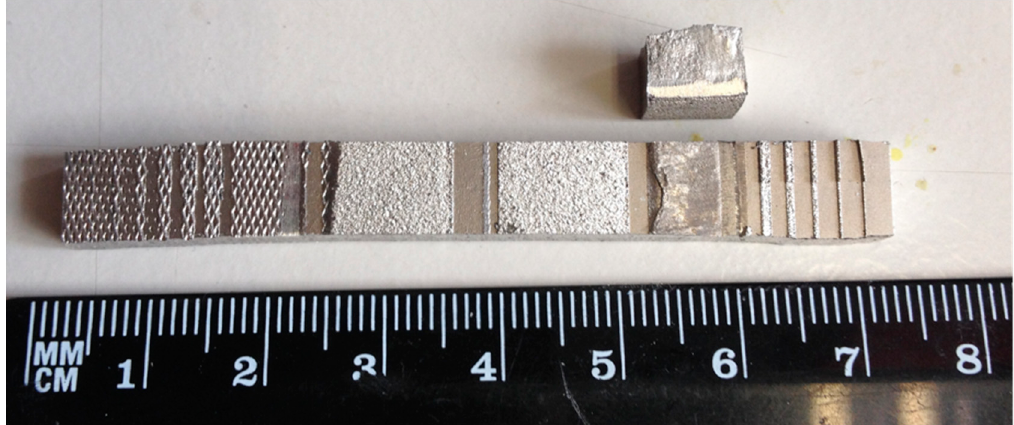
Figure 11. Fracture surface of a printed large ridge and substrate.